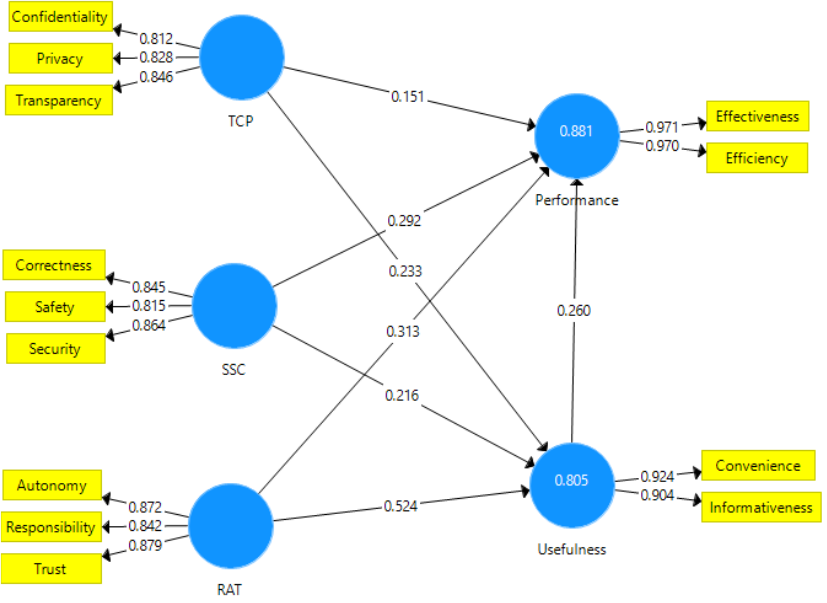
Figure 2. Empirical model. Source: elaborated by the author using SmartPLS v3.0 (SmartPLS GmbH, Oststeinbek, Germany).